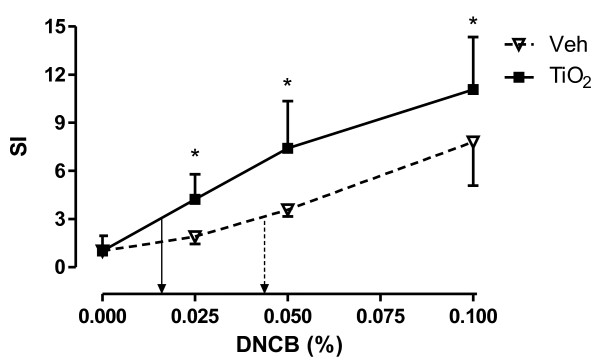
Effect of subcutaneous injections of 0.04 mg/mlTiO2NPs on the dose–response curve (SI) of DNCB sensitization. Mice were exposed to different doses of DNCB in the presence or absence of TiO2 NP pre-treatment (0.04 mg/ml). The EC3 value of Veh/DNCB is 0.041% (⇢), while the EC3 of TiO2/DNCB is 0.015% (→). Graph shows mean ± SD, n = 5-9, *p < 0.05.